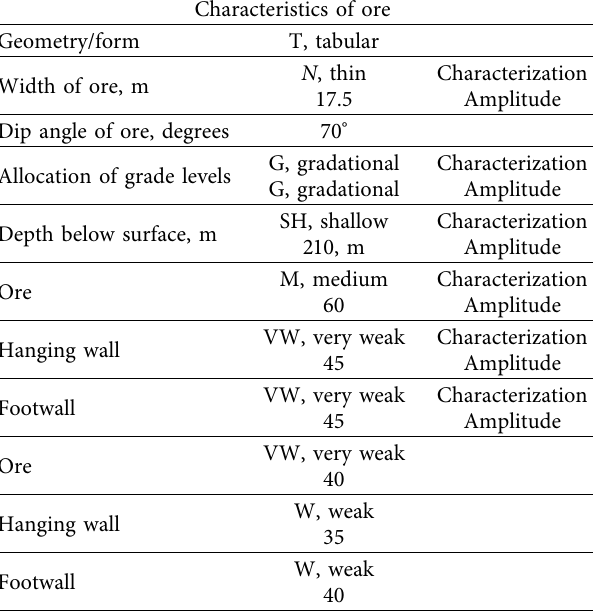
Table 4: Characteristic of underground mining